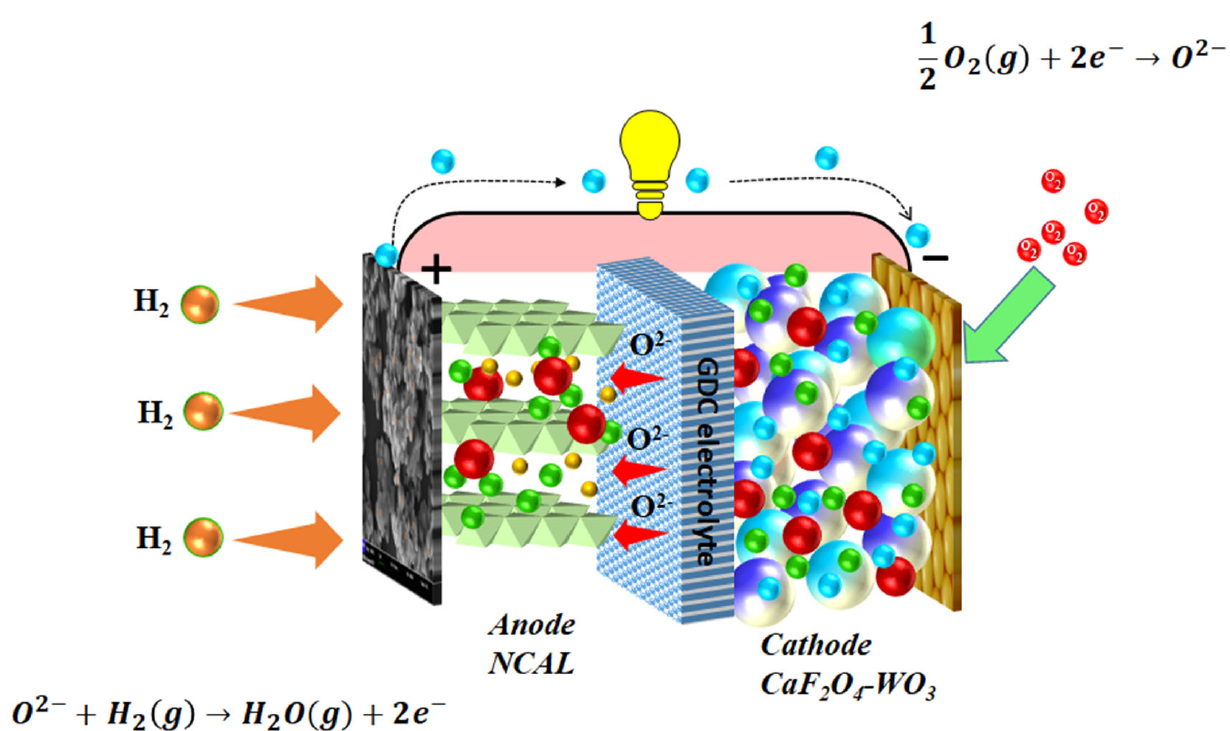
Figure 6. X ‐ ray photoelectron spectra of WO 3 ‐ CaFe 2 O 4 in comparison of pure WO 3 and CaFe 2 O 4 . ( a ) High ‐ resolution XPS spectra of W ‐ 4f in WO 3 and WO 3 ‐ CaFe 2 O 4 , ( b , c ) Ca ‐ 2p and Fe ‐ 2p XPS spectra of CaFe 2 O 4 and WO 3 ‐ CaFe 2 O 4 , respectively, and ( d ) O1s XPS spectra of CaFe 2 O 4 , WO 3, and WO 3 ‐ CaFe 2 O 4 , respectively.